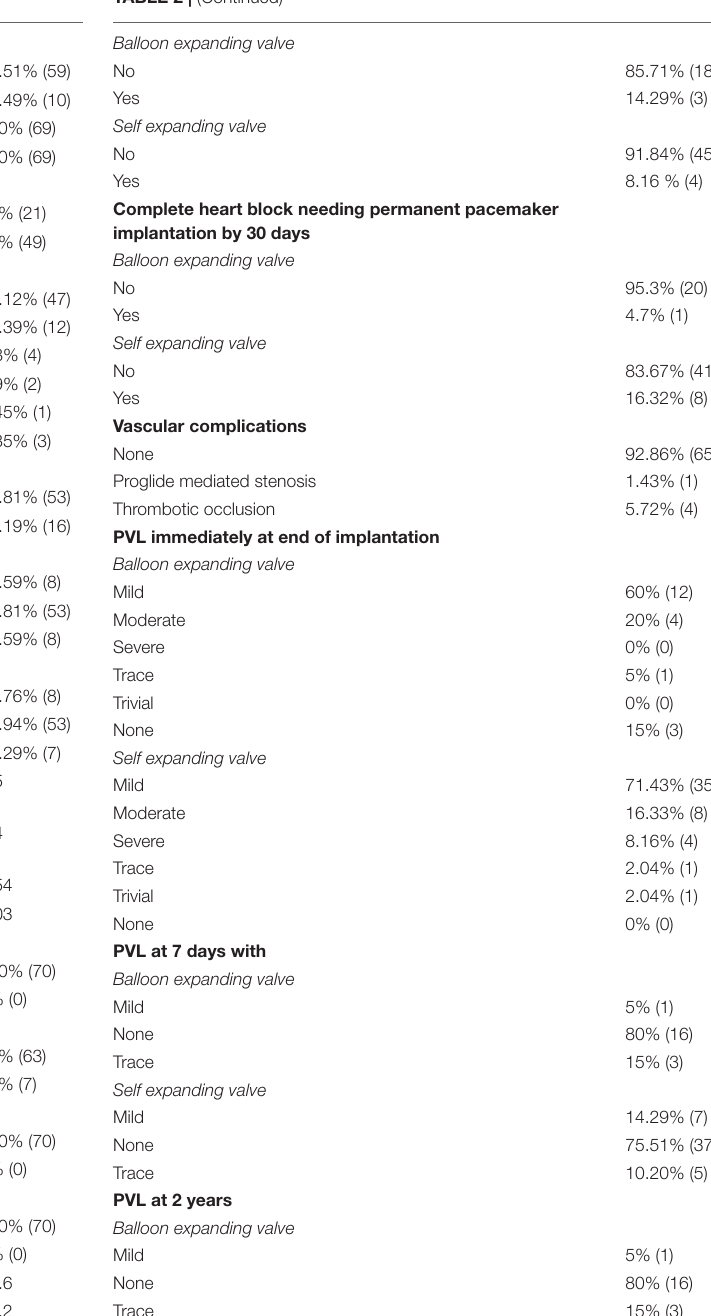
TABLE 2 | Procedural characteristics and